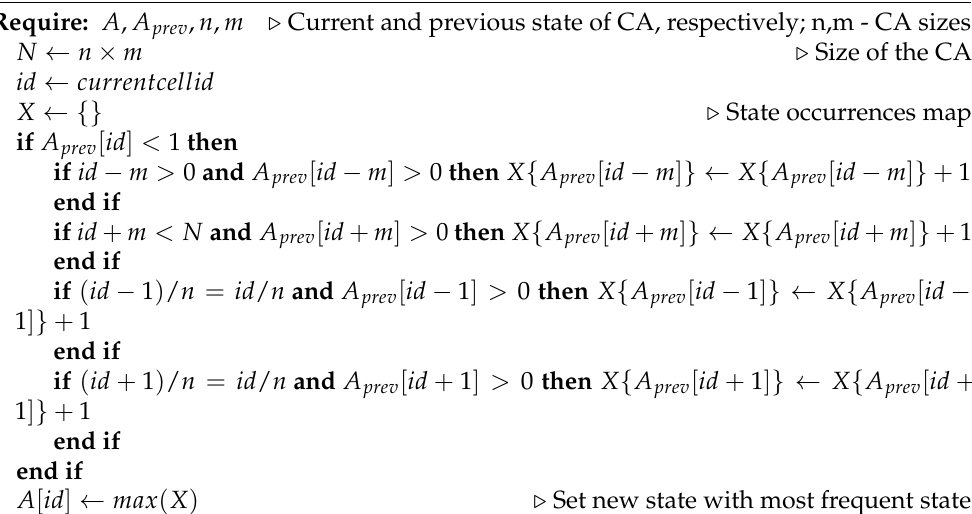
Algorithm 1 Cell’s state transition rule using Von Neumann neighborhood and absorbing boundary